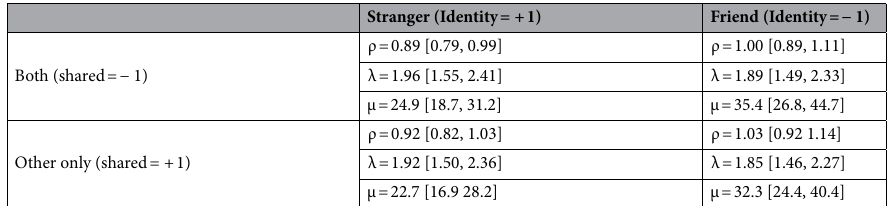
Table 1. Implied mean parameter values for the four social conditions observed in this study. Values are the implied mean estimates (with 95% HDI values in square brackets) for each of the four conditions defined by our 2 × 2 mixed between/within subjects design. Note that each cell contains the effects of Other, Sharing, and Identity, paired with the correct indicator variables and combined with baseline estimates of risk attitudes, loss aversion, and choice consistency. Values of rho ( ρ ) capture risk attitudes; when ρ = 1, participants are risk- neutral. Values < 1 indicate risk aversion while values > 1 indicate risk-seeking (for gains; opposite pattern for losses). Values of lambda (λ) capture loss aversion. When λ = 1, participants are gain–loss neutral. Values > 1 indicate loss aversion, while those < 1 indicate gain-seeking. Values of mu ( μ ) capture consistency, with higher values indicating greater consistency. Values compare to Self estimates of ρ = 1.07 [0.96 1.18], λ = 1.78 [1.42, 2.19], and μ = 18.0 [13.7, 22.1] (see